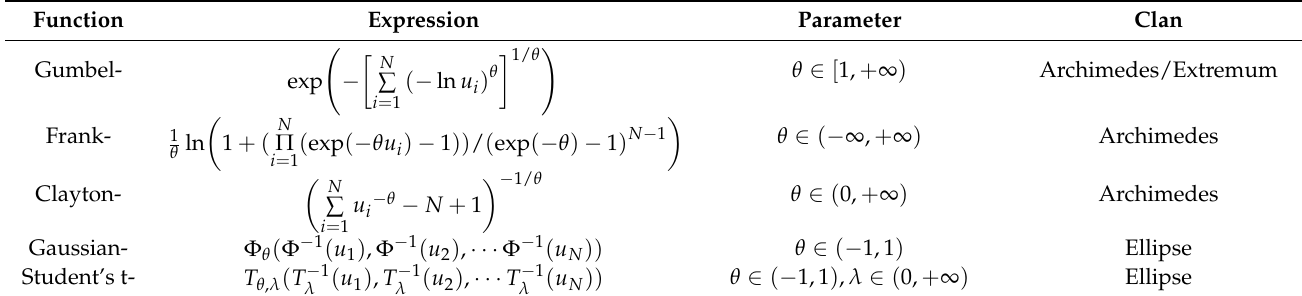
Table 1 lists some commonly used copula functions. Table 1. Commonly used copula